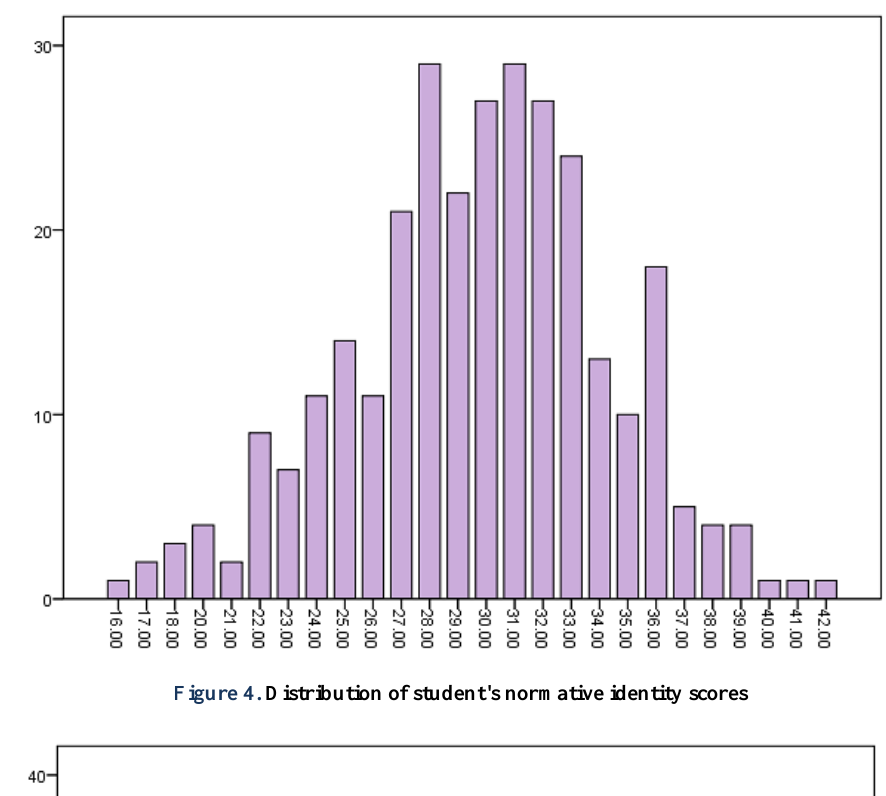
Figure 4. Distribution of student's normative identity scores